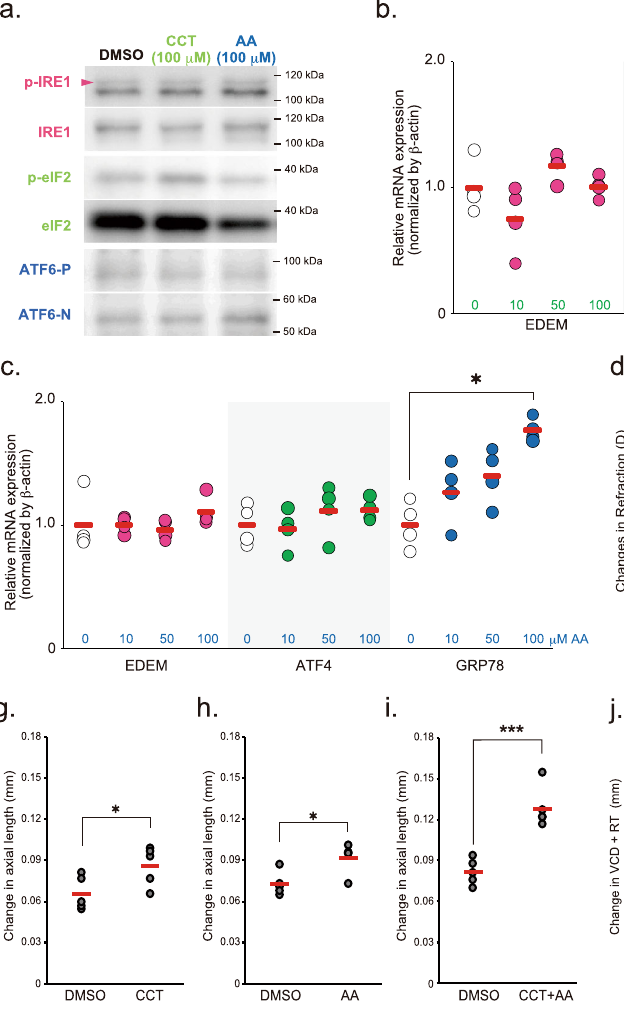
Fig. 7 | Effect of PERK and ATF6 agonizts instillation on myopia development. a EffectofPERKagonistCCT020312(CCT)andATF6agonistAA147(AA)instillation on IRE1, eIF2 and ATF6 activity in sclera. One hour after eye drop, the sclerae were harvestedandsubjectedtoWesternblotting.Eachcompoundspeci fi callyactivated each pathway. b GRP78, ATF4, and EDEM gene expression induced by CCT. Each zero group was assigned a value of 1.0. * p =0.029, compared to 0 (as a control) group; one-way ANOVA with Tukey HSD ( n =4, respectively). c GRP78, ATF4, and